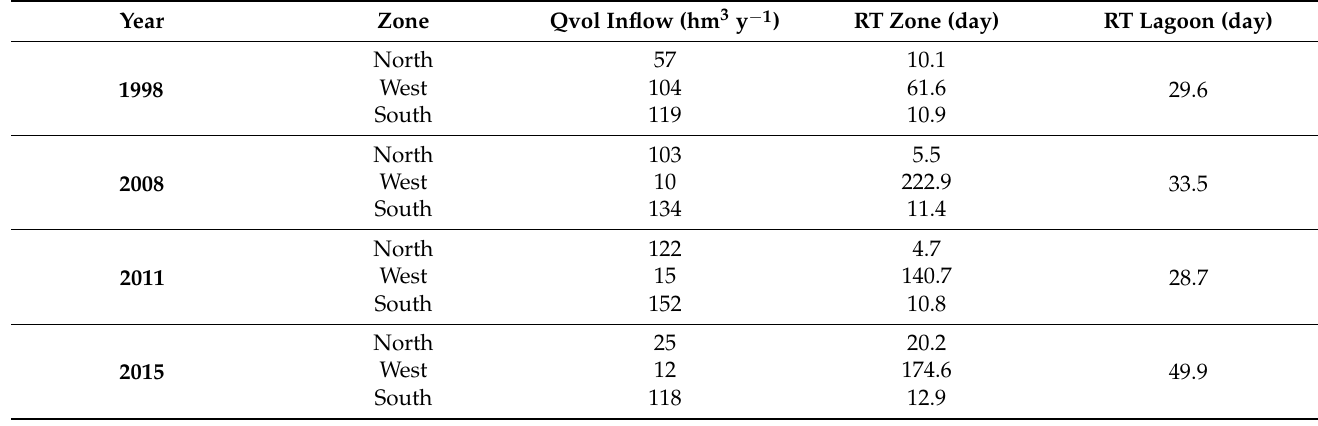
Table 2. Time of residence in different years for each of the zones considered and for the entire lagoon. Qvol indicates the volume of water provided in each zone; RT, residence time.